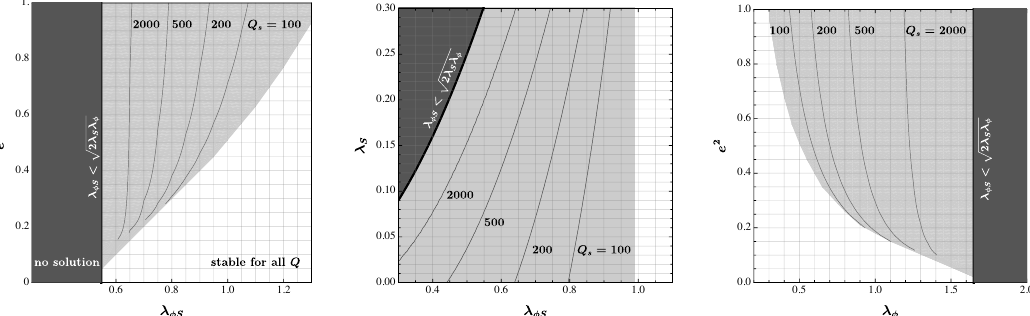
Figure 3 . Contours of the minimum stable S charge Q s for QMBs with magnetic charge q = 2 . When a Lagrangian parameter is not varied on the x - or y -axis, it is fixed to λ φ = 0 . 5 , e 2 = 0 . 5 , λ S = 0 . 3 , λ φS = 1 , and m S, 0 = 0 . In the dark shaded regions, no Q-ball state exists of any kind, mixed QMB or isolated Q-ball. In the light shaded regions, Q > Q s is required for a stable solution. For Q < Q s , the states decay to Q free S particles and an isolated monopole. The contours in the left and right panels should extend all the way to the dark shaded regions but are truncated due to limited numerical precision. In the white unshaded regions, all S charges Q down to unity are